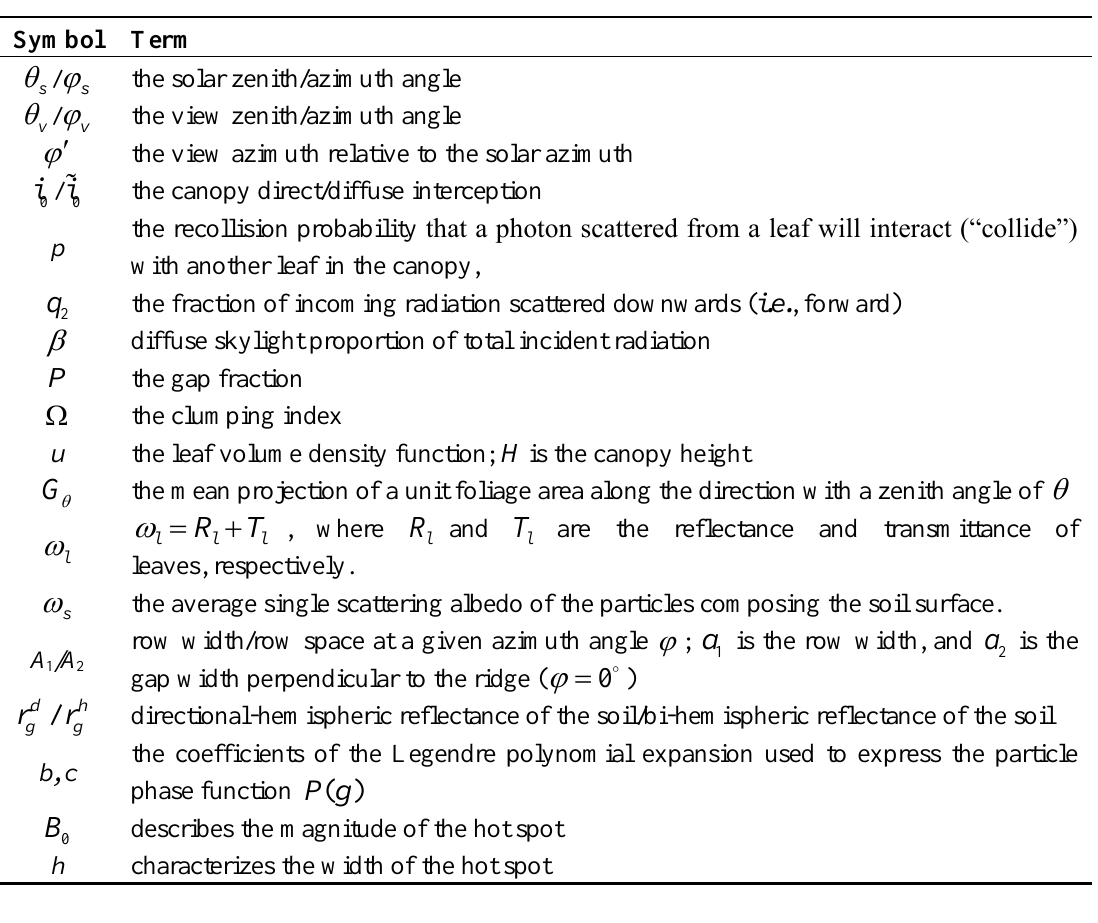
Figure 1. Illustration of the composition of soil absorption. Table 1. Explanations of the symbols in the albedo model (the last four lines list the unknown parameters in the Hapke